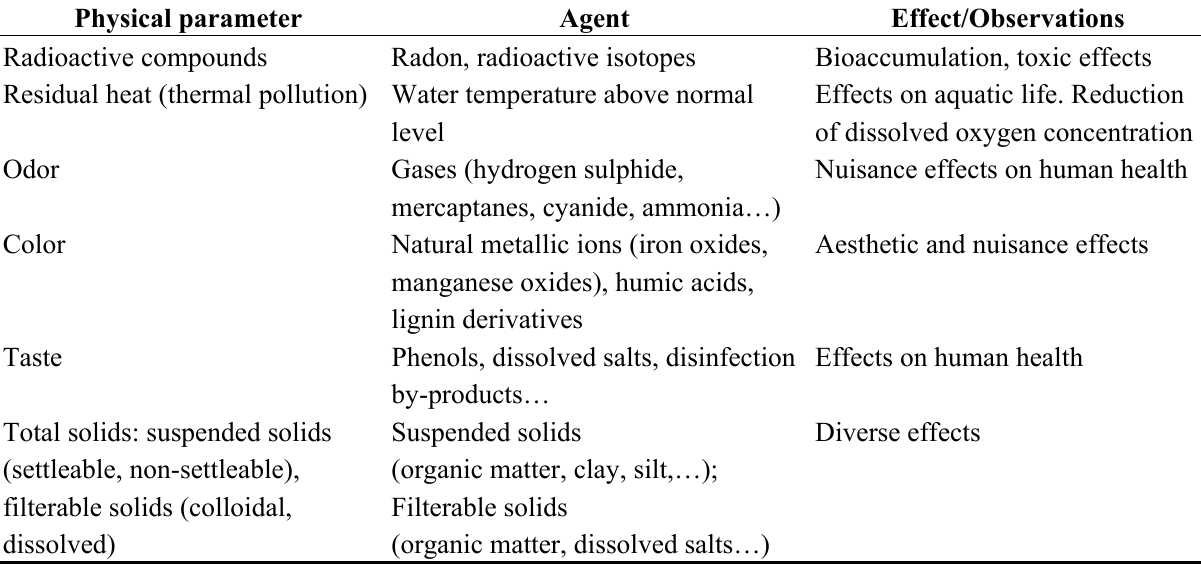
Table 5. Physical pollution potentially present in urban wastewater (modified from [24,25]).